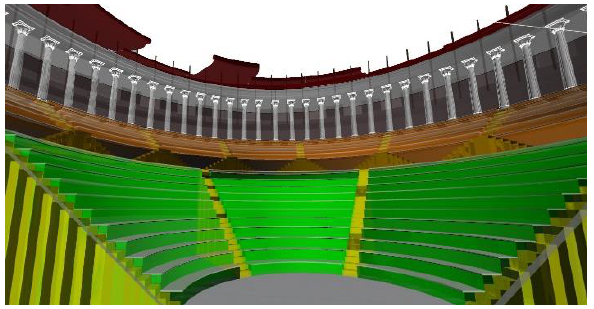
Figure 12: A first hypothetical reconstruction of the Theatre.